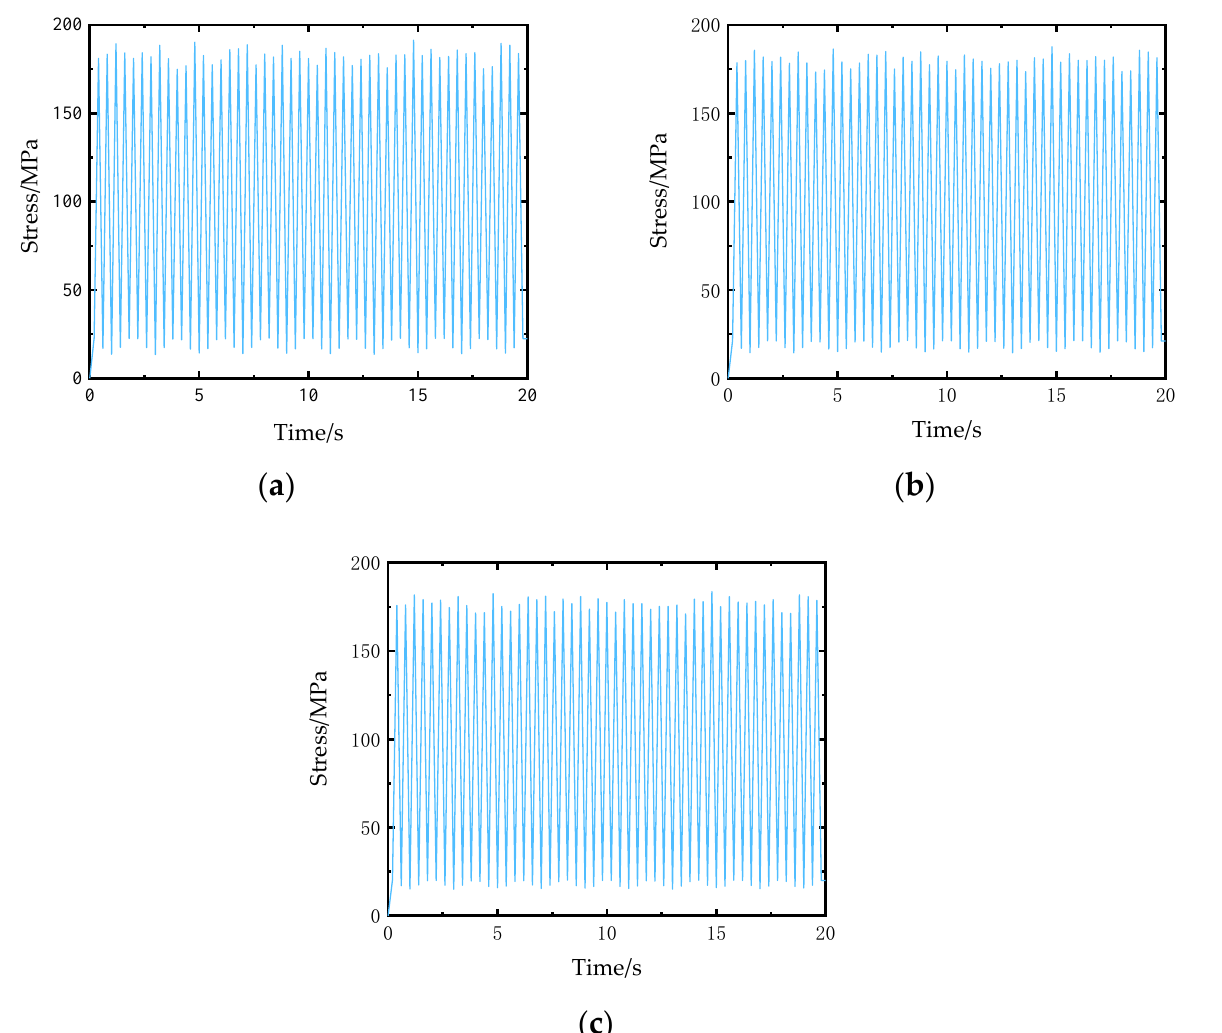
Figure 11. Sub-model at the center in macroscopical element.